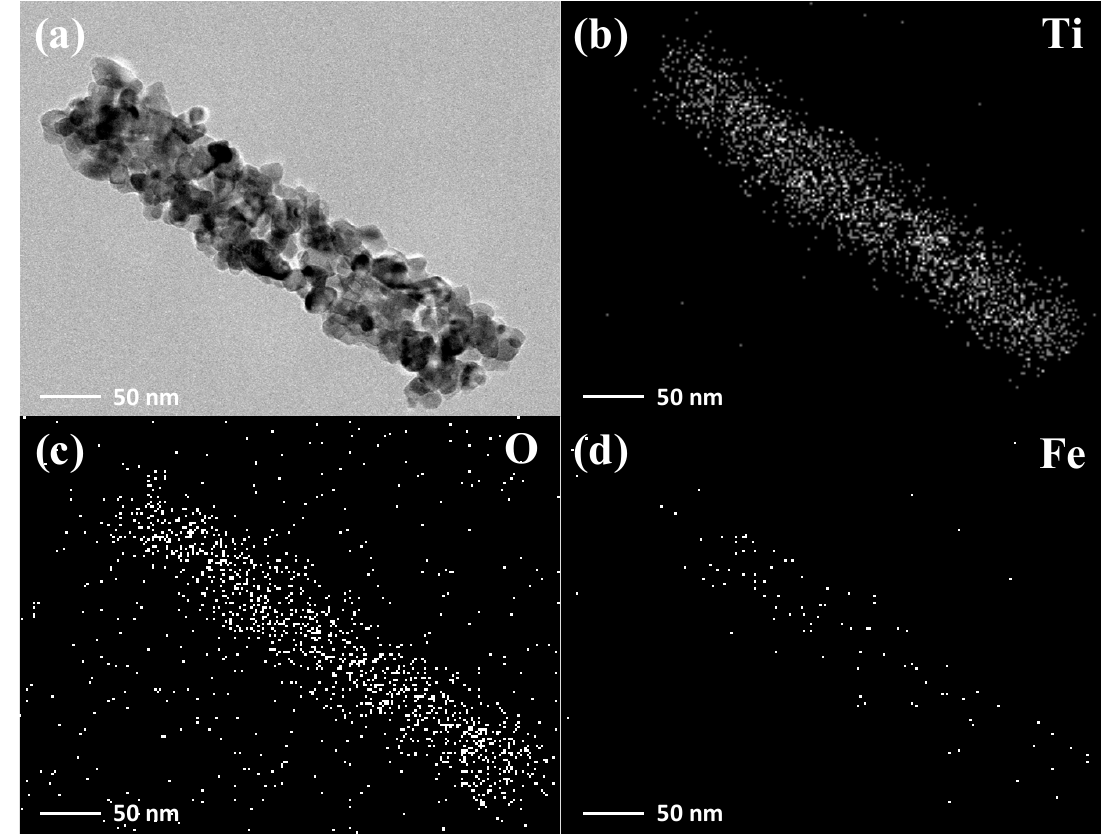
Figure 3. TEM image of 0.2 mol / L Fe 3 + doped singleTiO 2 nanotube ( a ), and EDS mapping of Ti ( b ), O ( c ), and Fe ( d ) in the singleTiO 2 nanotube.